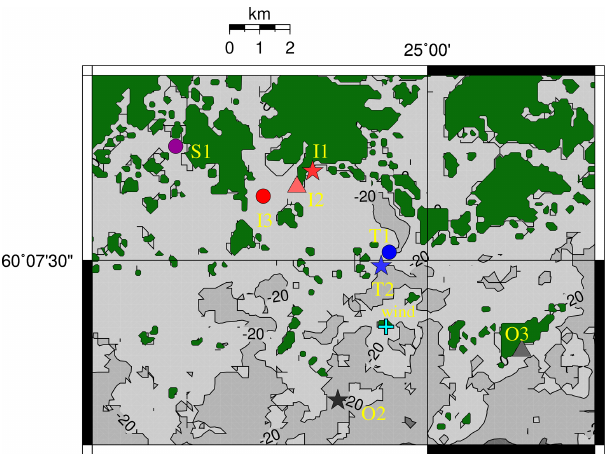
Figure 2. A more detailed map of the measurement locations close to the Helsinki shoreline. This area is marked with a black box in Fig. 1. See the caption of Fig. 1 for the explanation of the